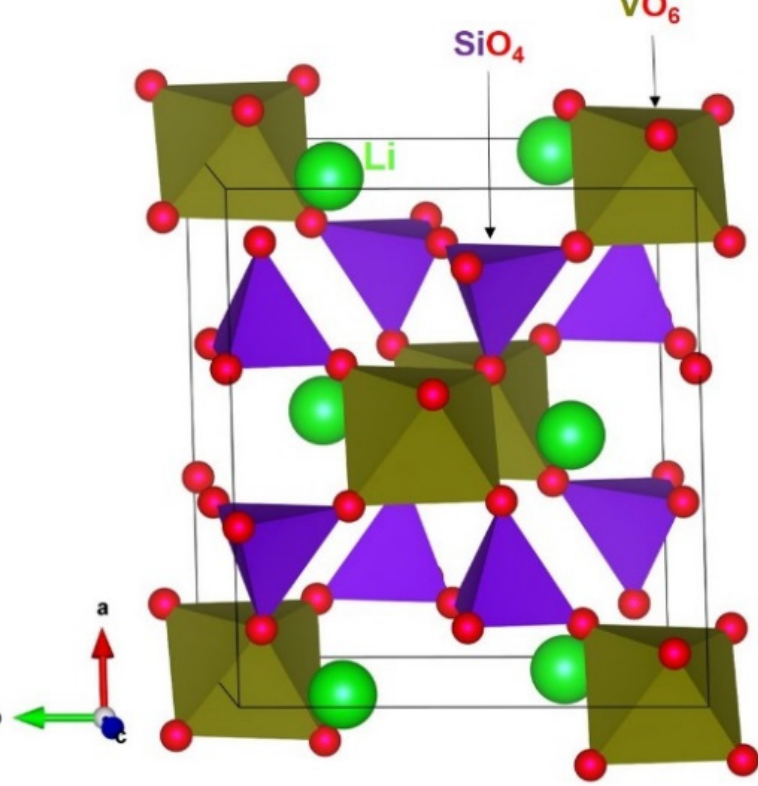
Figure 1. Crystal structure of LiVSi 2 O 6 (ICSD_CollCode55164.cif) [50] generated using the VESTA (Visualization for Electronic and STructural Analysis) [52] visualisation program. Table 2. Calculated and experimental lattice parameters of bulk LiVSi 2 O 6 and NaVSi 2 O 6 .